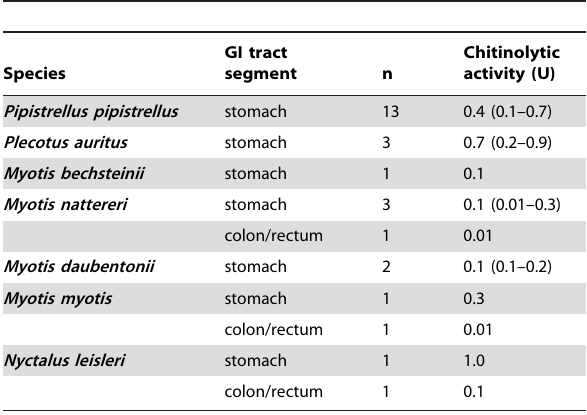
Table 2. Median chitinolytic activity (min–max) (U) in the GI tract of studied bat species.